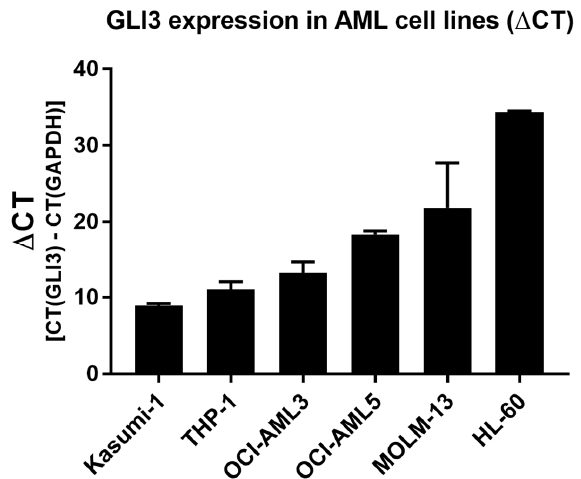
Figure A3. Expression levels of GLI3 in di ff erent AML cell lines. GLI3 expression in AML cell